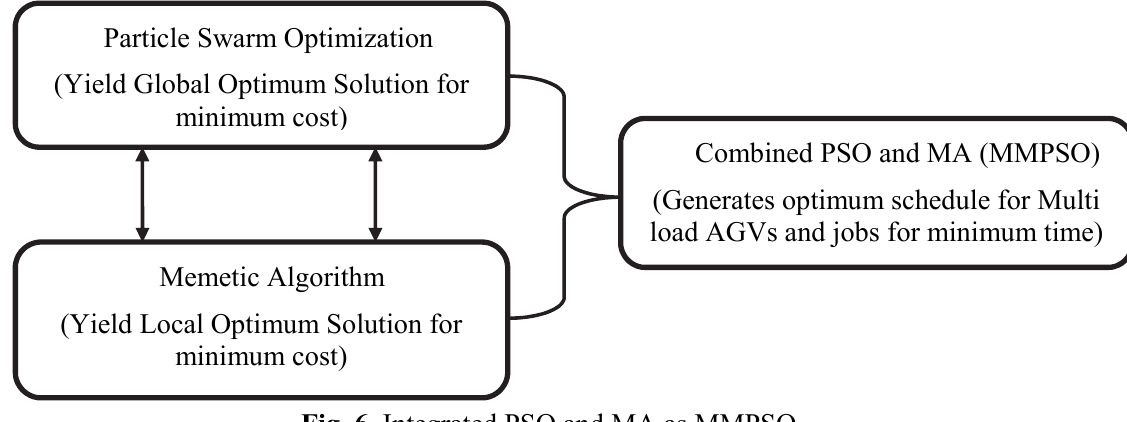
Fig. 6. Integrated PSO and MA as